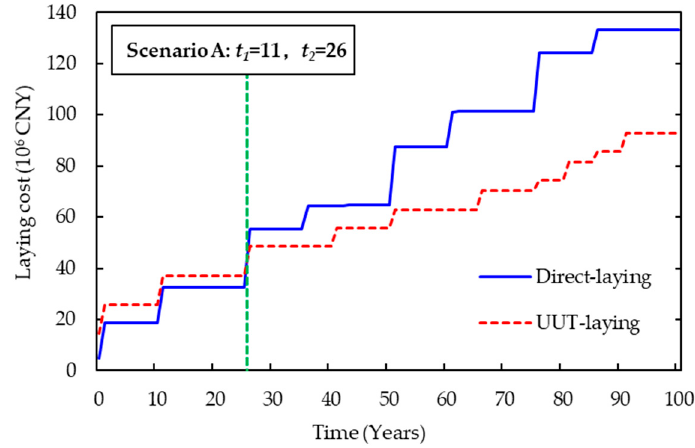
Energies 2019 , 12 , x FOR PEER REVIEW Figure 6. Comparison of power pipeline laying costs under Scenario A. Figure 6. Comparison of power pipeline laying costs under Scenario A.